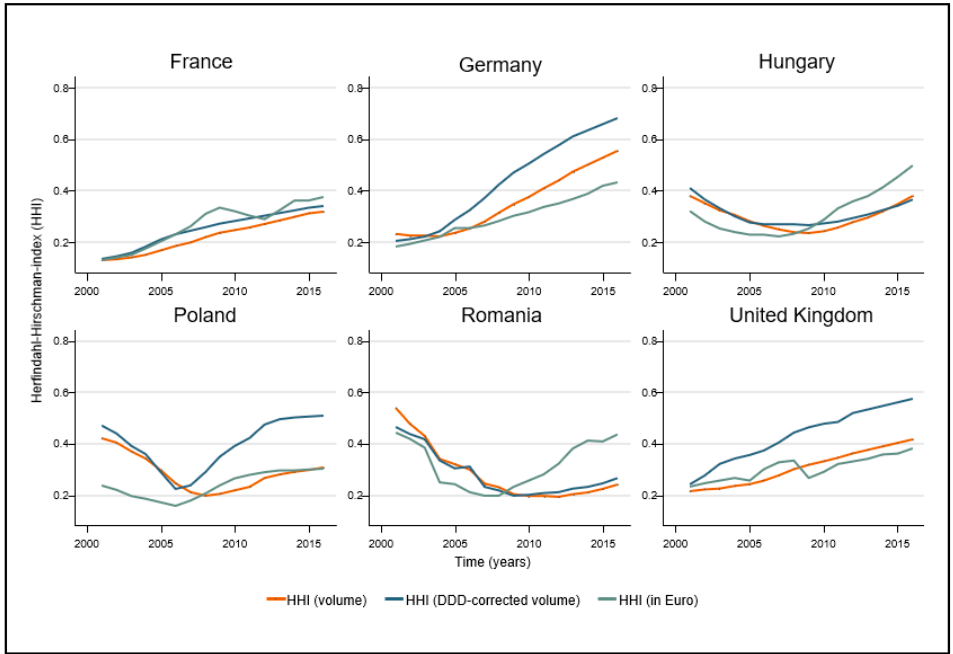
Figure 5. Market concentration of ACE inhibitor active ingredients in six European countries from 2001 to 2016.